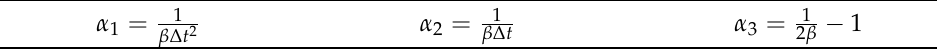
Table 1. The α -parameters of the Newmark